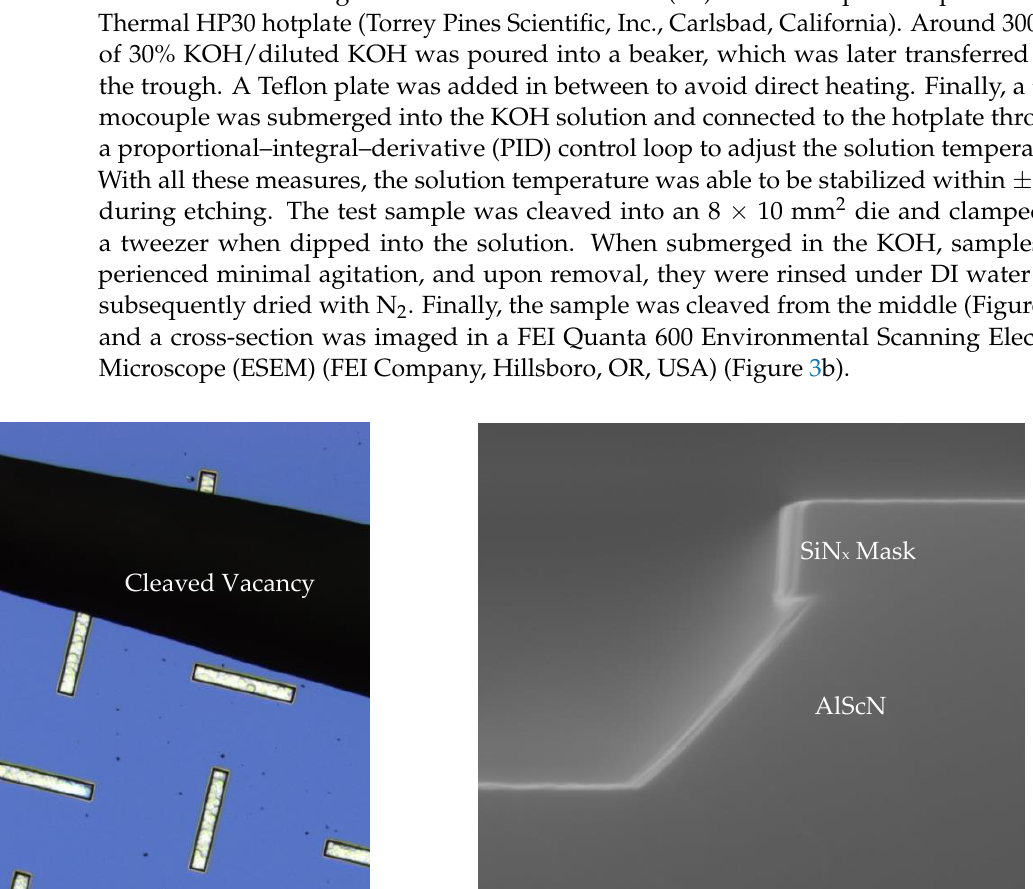
Figure 2. ( a ) Al 1 − x Sc x N and SiN x hard mask deposition; ( b ) photoresist patterning; ( c ) SiN x dry etch; ( d ) resist stripping and Al 1 − x Sc x N KOH wet etch. The opening area for the etching is 30 × 200 µm 2 .